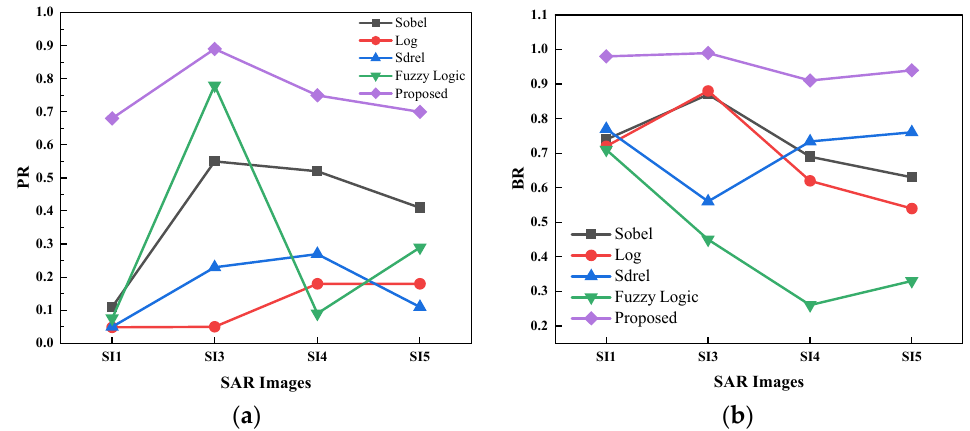
Figure 11. Five edge extraction results for four images. ( a ) Sobel, ( b ) Log, ( c ) SDREL, ( d ) fuzzy logic, and ( e ) the proposed method.